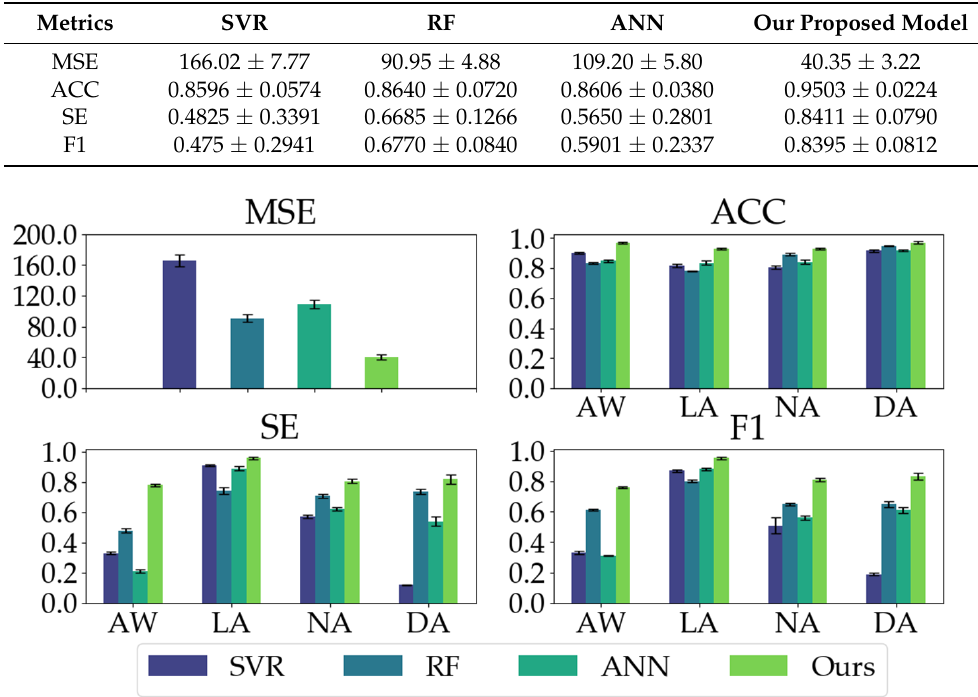
Figure 8. The classification performances (ACC, SE, and F1) of all the models on different anesthetized states (AW, LA, NA, and DA) and the regression performance (MSE) of all the models.